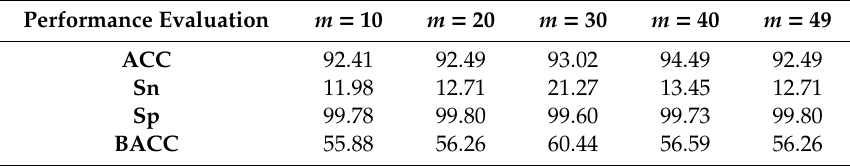
Table 4. The prediction overall accuracy of ECM proteins by selecting di ff erent m values.